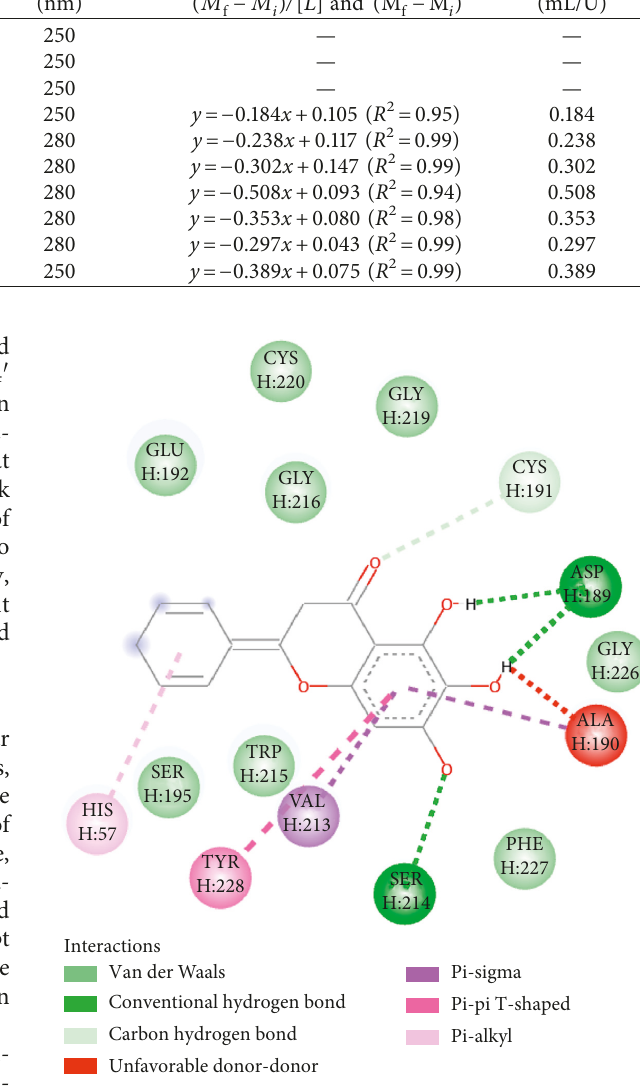
Figure 4: The 2D interaction diagram of baicalein with residues of